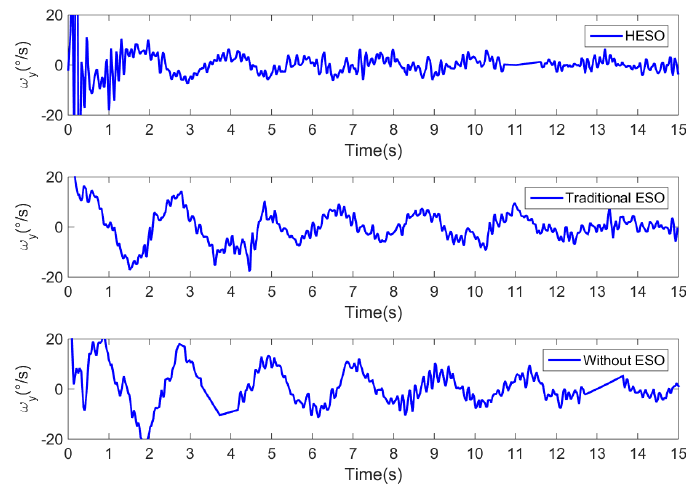
Figure 11. Experimental curves of ω y with different ESO. Table 2. Comparison of control performance in the tracking error of pitch angle with different ESO (RMS error).